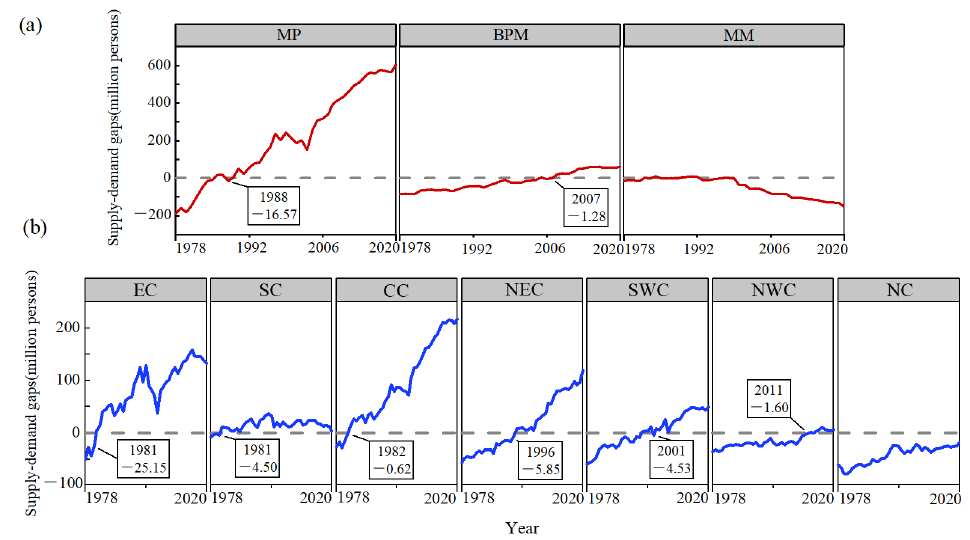
Figure 6. Food caloric supply–demand gap changes in ( a ) production and marketing sub-regions and ( b ) physical geographic divisions. The box marks the last year when the supply deficiency occurred and its deficiency (million persons).